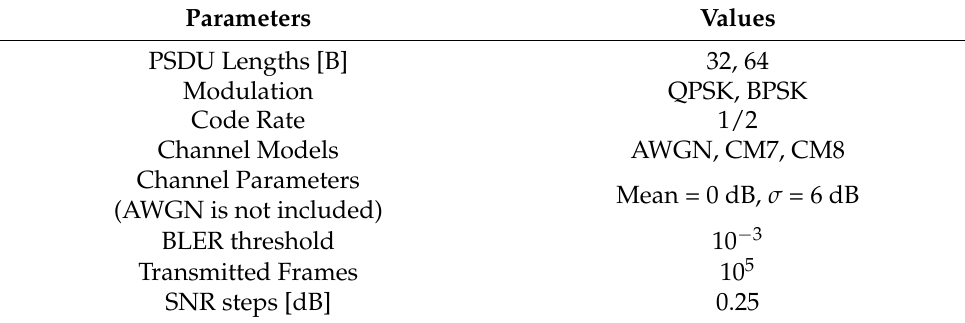
Table 2. Simulation